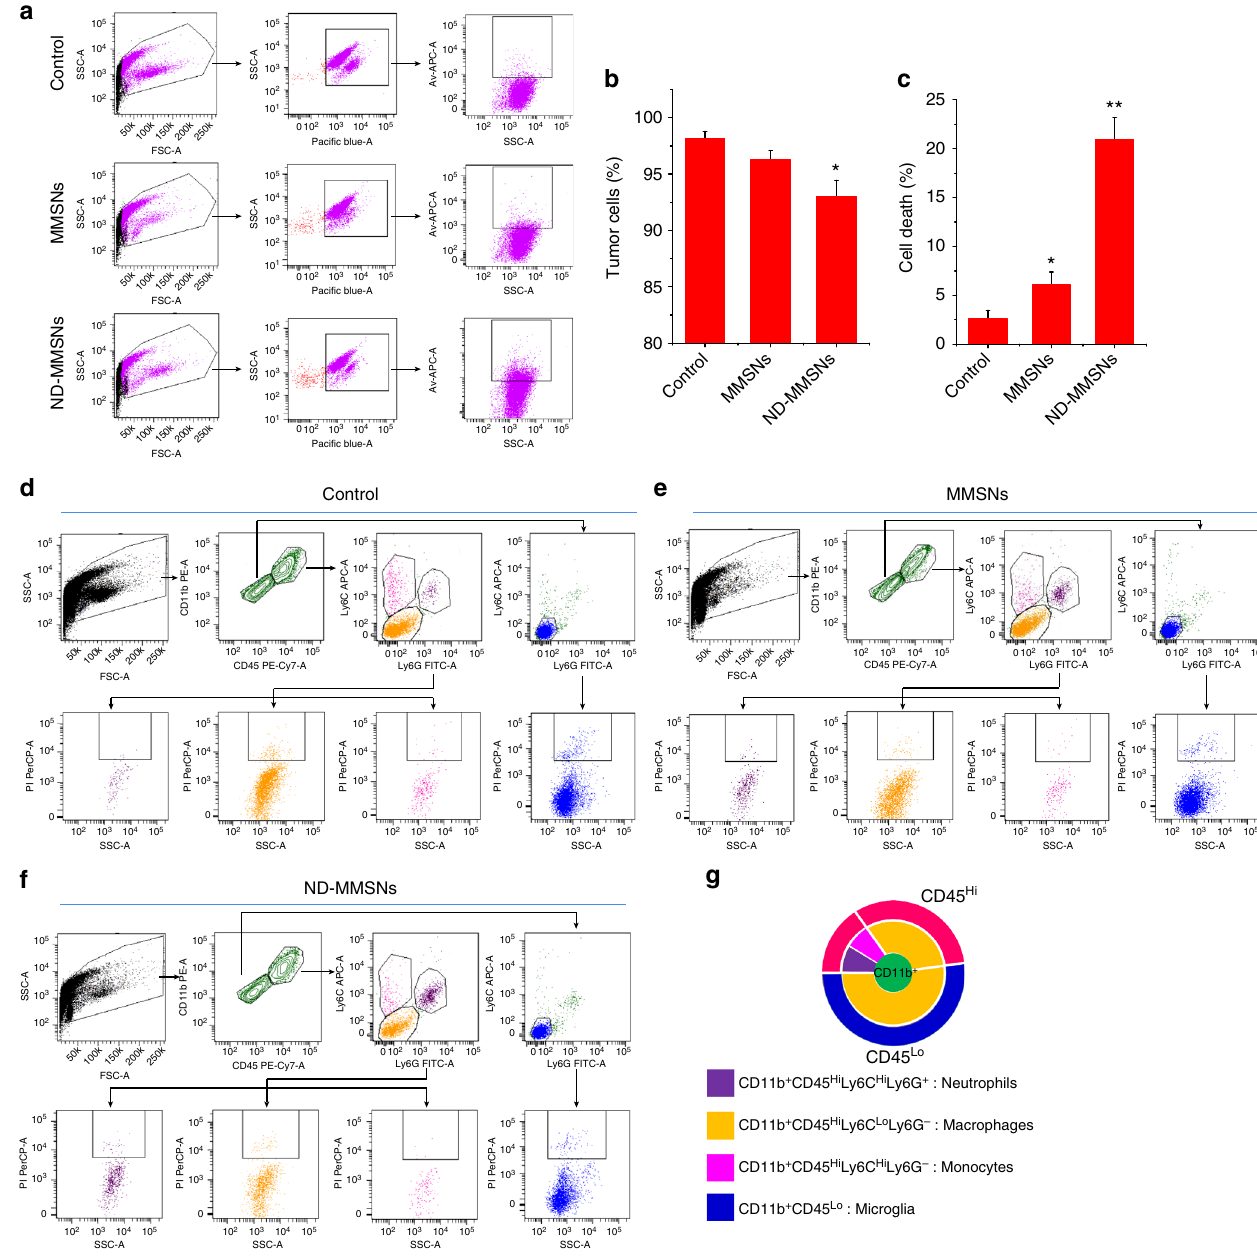
Fig. 7 Flow cytometry evaluation of in vivo therapeutic mechanisms. a − c The single tumor cell suspension was stained by D -luciferin potassium salt and APC-labeled Annexin V apoptosis detection kit. The tumor cell ratio and the apoptotic tumor cells were determined by fl ow cytometry. Luciferin fl uorescence that stands for tumor cells was detected with Paci fi c blue channel. Mean values and error bars are de fi ned as mean and s.d., respectively ( n = 3). Statistical signi fi cance is assessed by Student ’ s two-sided t test compared to the control group. * P < 0.05 and ** P < 0.01. d − f Representative dot plots gated on the CD45 + CD11b + cells from tumors generated in U87 mice. The total population of CD45 + CD11b + cells is considered to be 100%, with CD11b + CD45 Hi (neutrophils, monocytes, and macrophages) and CD11b + CD45 lo (resident brain microglia) populations gated separately. Their expression of Ly6C and Ly6G was analyzed and the percentage of each subpopulation was quanti fi ed. The apoptotic cells in each subpopulation were also determined by PI. g Schematic diagram of tumor-associated macrophage